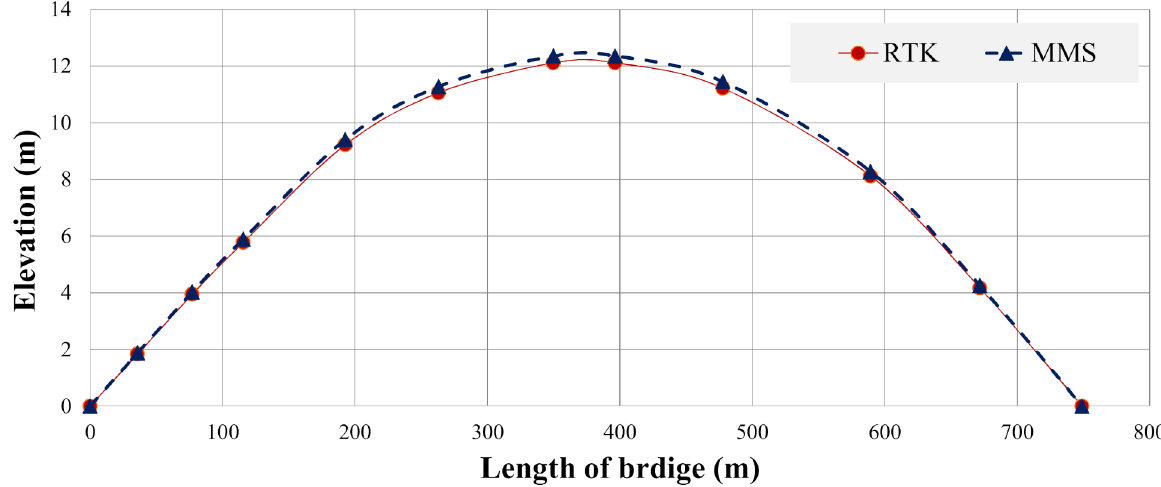
Figure 11. Comparison of bridge profile measured by RTK and